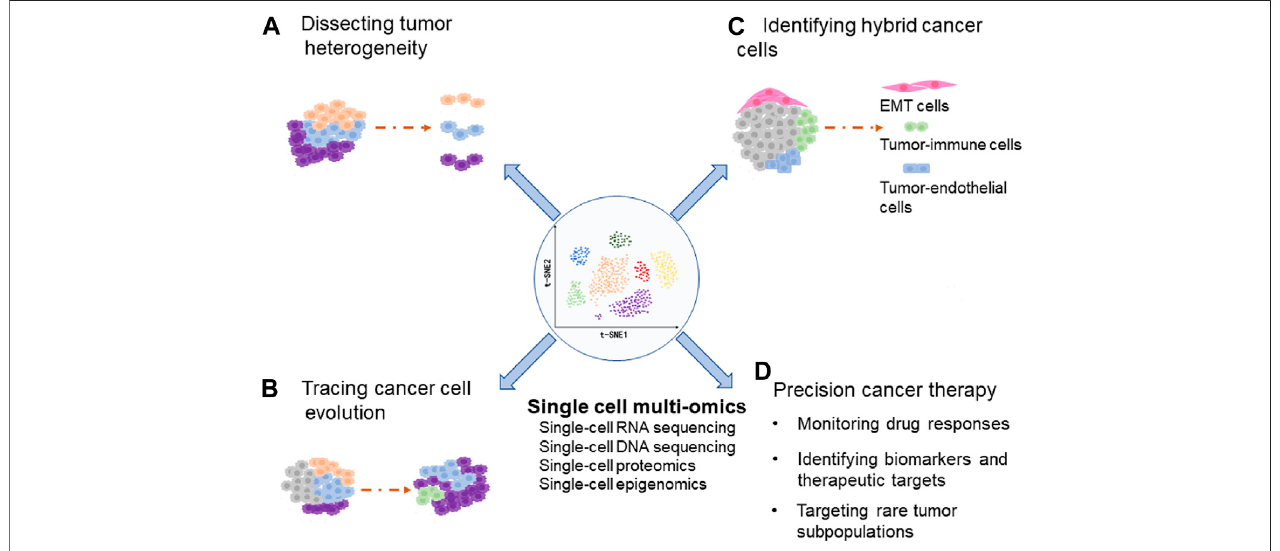
FIGURE 1 | The diagram indicates applications of single-cell multi-omics in dissecting tumor heterogeneity (A) , tracing cancer cell evolution (B) , identifying hybrid cancer cells (C) , and precision cancer therapy (D) .